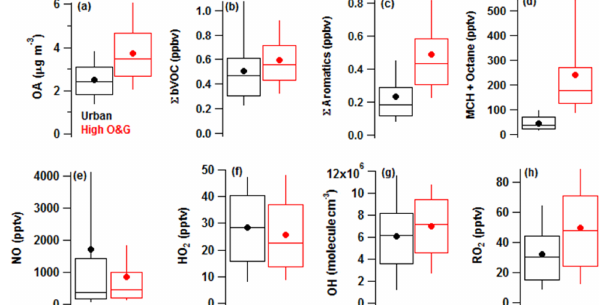
Figure 4. Statistical analysis of measured OA (a) , various hydro- carbons (sum of biogenic VOCs, bVOC, defined as isoprene + 2 × (methyl vinyl ketone + methacrolein) + monoterpenes (b) ; sum of aromatic VOCs defined as benzene + toluene + C 8 aromatics + C 9 aromatics (c) ; sum of methylcyclohexane and octane (d) ), NO (e) , and radicals (HO 2 (f) , OH (g) , and RO 2 (h) ) in urban- and high- O&G-influenced plumes. Box and whisker plots depict the 10th, 25th, 50th, 75th, and 90th percentiles. Mean values in each plume type are shown in